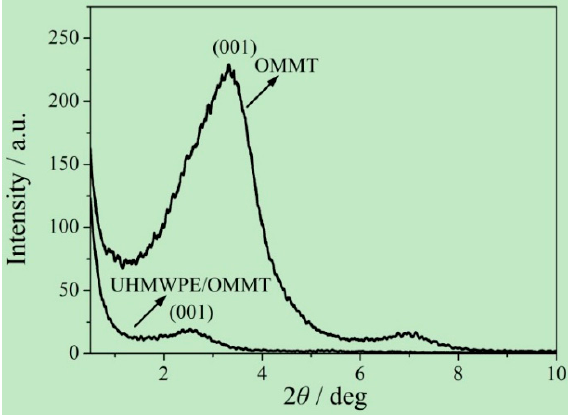
Figure 6. Small-angle XRD curves of OMMT and OMMT-modified UHMWPE.